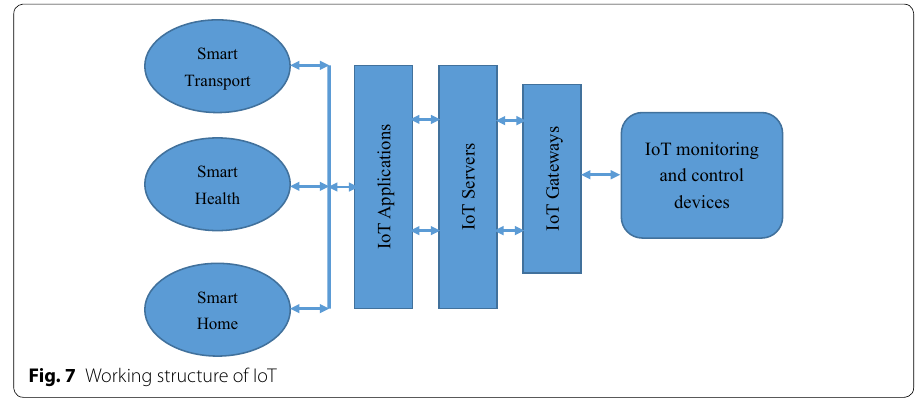
Fig. 7 Working structure of IoT